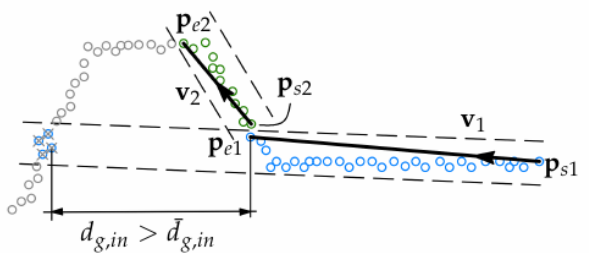
Figure 7. Procedure of searching the two first line segments using RANSAC. Inliers of segment 1 are shown in blue. These inliers, excluding the inliers separated by the gap d g , in > ¯ d g , in , are used for defining the segment. After segment 1 is defined, the best inlier set for segment 2 is found, which is shown in green, and segment 2 is defined.